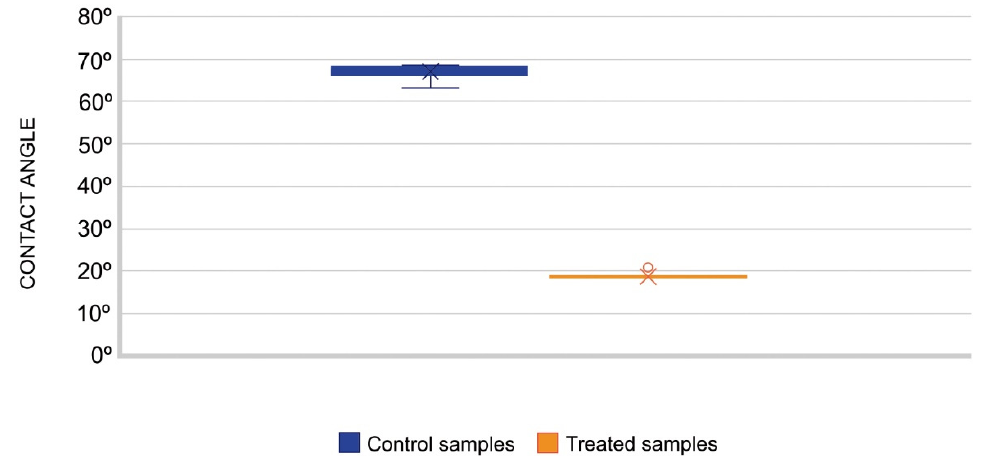
Figure 4. Boxplots showing the contact angle obtained for the control samples (blue) with its median (67.8 ◦ ), minimum (63.2 ◦ ), and maximum (68.6 ◦ ); and the treated samples (orange) with its median (18.65 ◦ ), minimum (18.3 ◦ ), and maximum (20.8 ◦